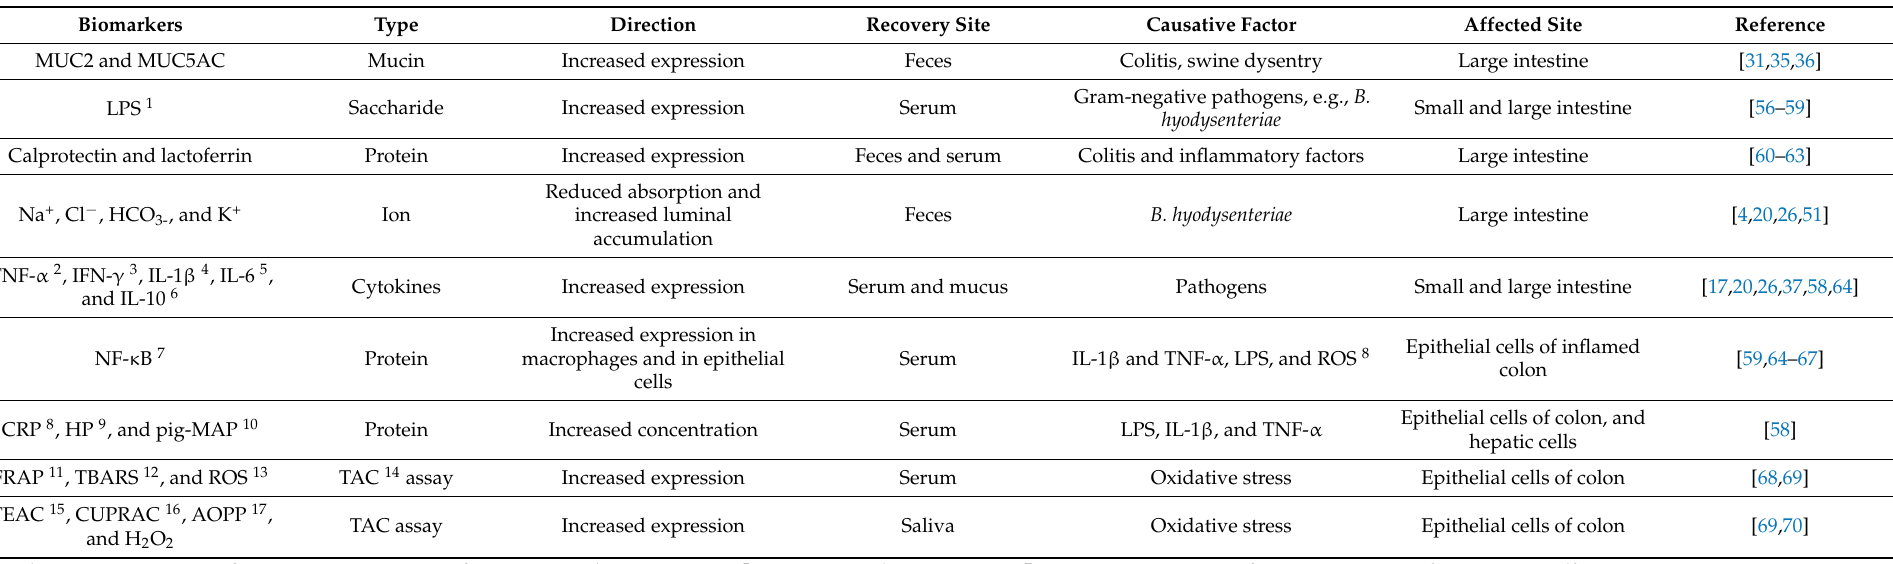
Table 2. Summary of non-invasive putative biomarkers associated with colonic